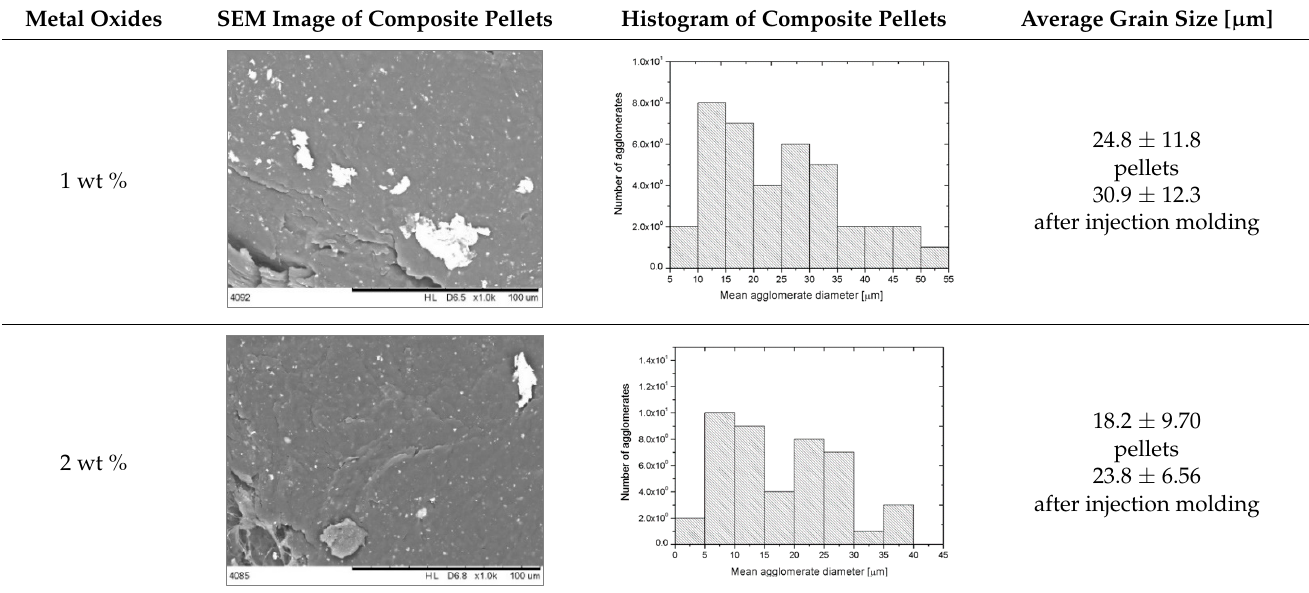
Figure 3. XPS analysis of the filler before ( a ) and after ( b ) interaction with PA12. The comparison of Cu 2p, Zn 2p and Ti 2p spectra.